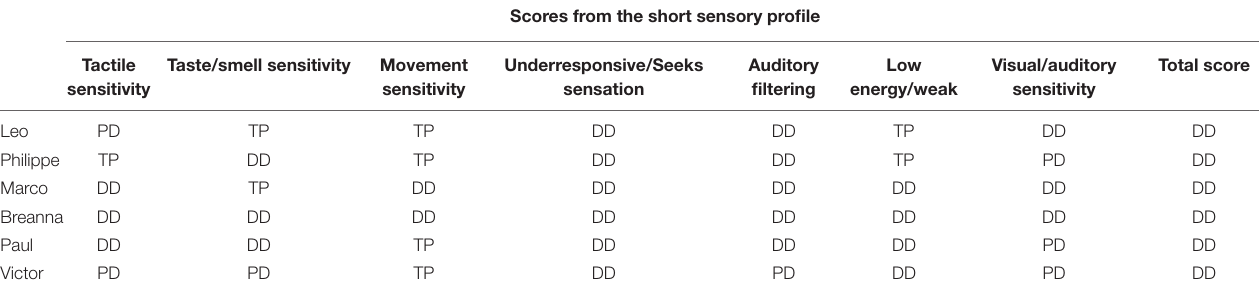
TABLE 2 | Scores from the Short Sensory Profile (SSP) of the autistic individuals implicated in the participatory photovoice project through 2014–2016 (PV1). Scores from the short sensory